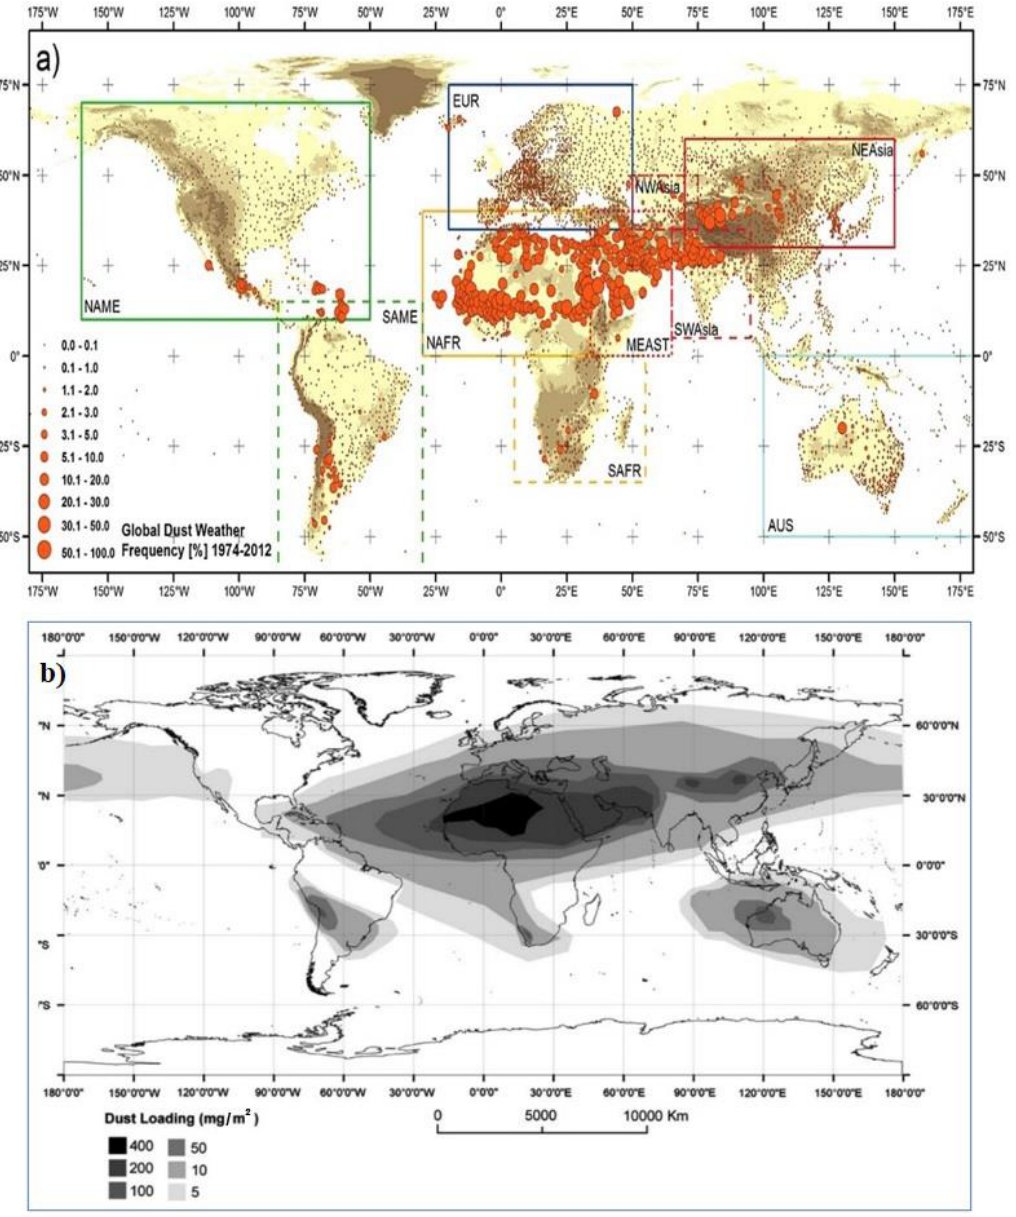
Figure 10. ( a ) A global scale of dust frequency for the period of January 1974 to December 2012 according to [50]; ( b ) dust load spatial distribution showing hot spots sourced from Africa, according to [51].